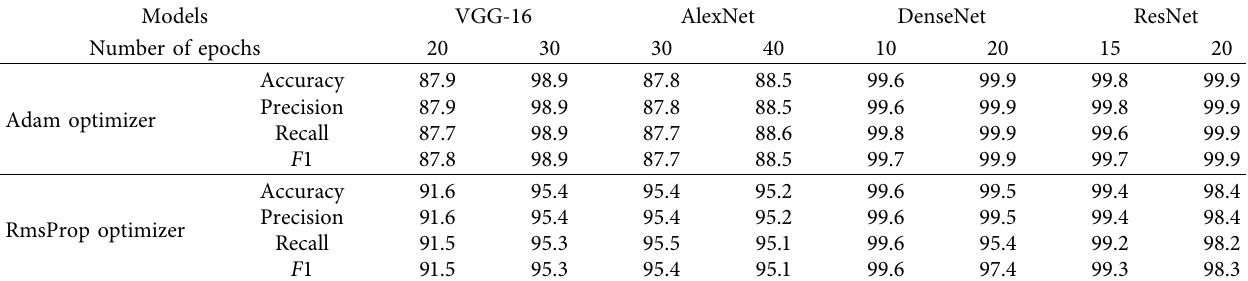
Table 3: Accuracy, precision, recall, and F 1 of VGG-16, AlexNet, DenseNet, and ResNet using Adam and RmsProp.